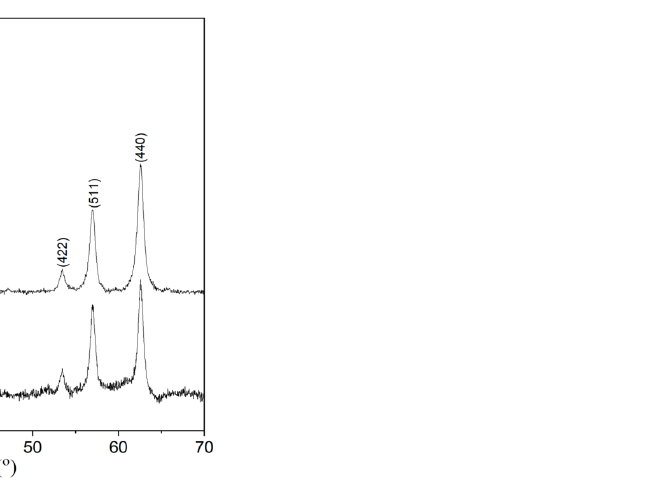
Figure 1. X-ray diffraction patterns of ( a ) as-received and ( b ) annealed at 800 ◦ C for 1 h in the air CoFe 2 O 4 powder.